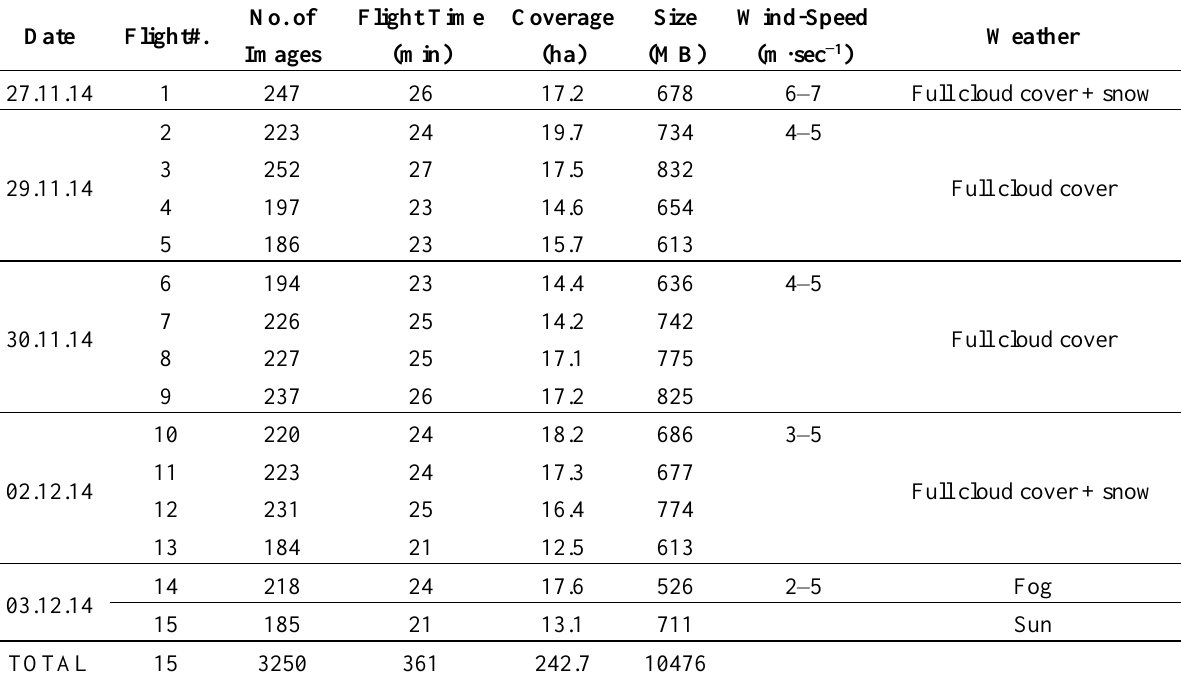
Table 2. Summary of flight characteristics for each flight block of imagery